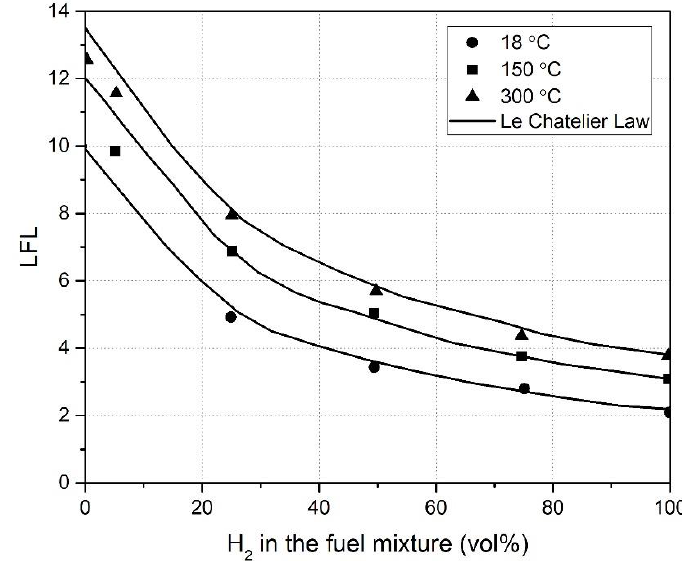
Figure 8. Lean flammability limits of H 2 -CO mixtures in the air at different temperatures. The solid line represents the calculated value by Le Chatelier Law using individual limit values of each fuel type. Reproduced from Ref. [7], International Association for Hydrogen Energy: 2001.